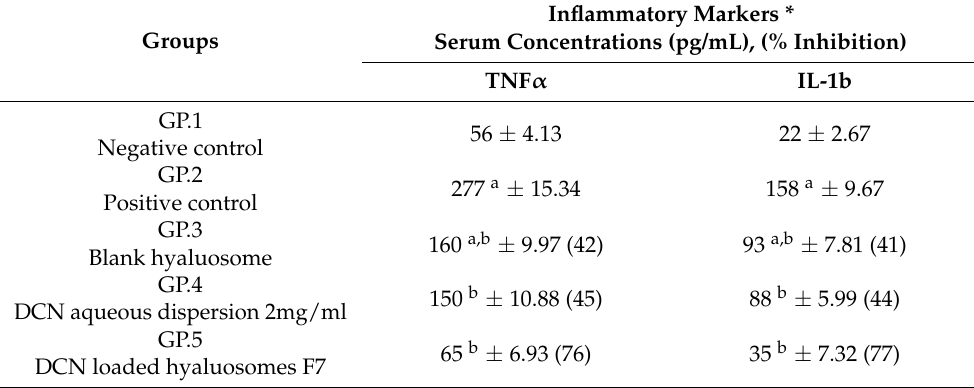
Table 3. Results of the rat’s plasma TNF- α and IL-1b levels measured after 4 weeks of osteoarthri- tis induction.